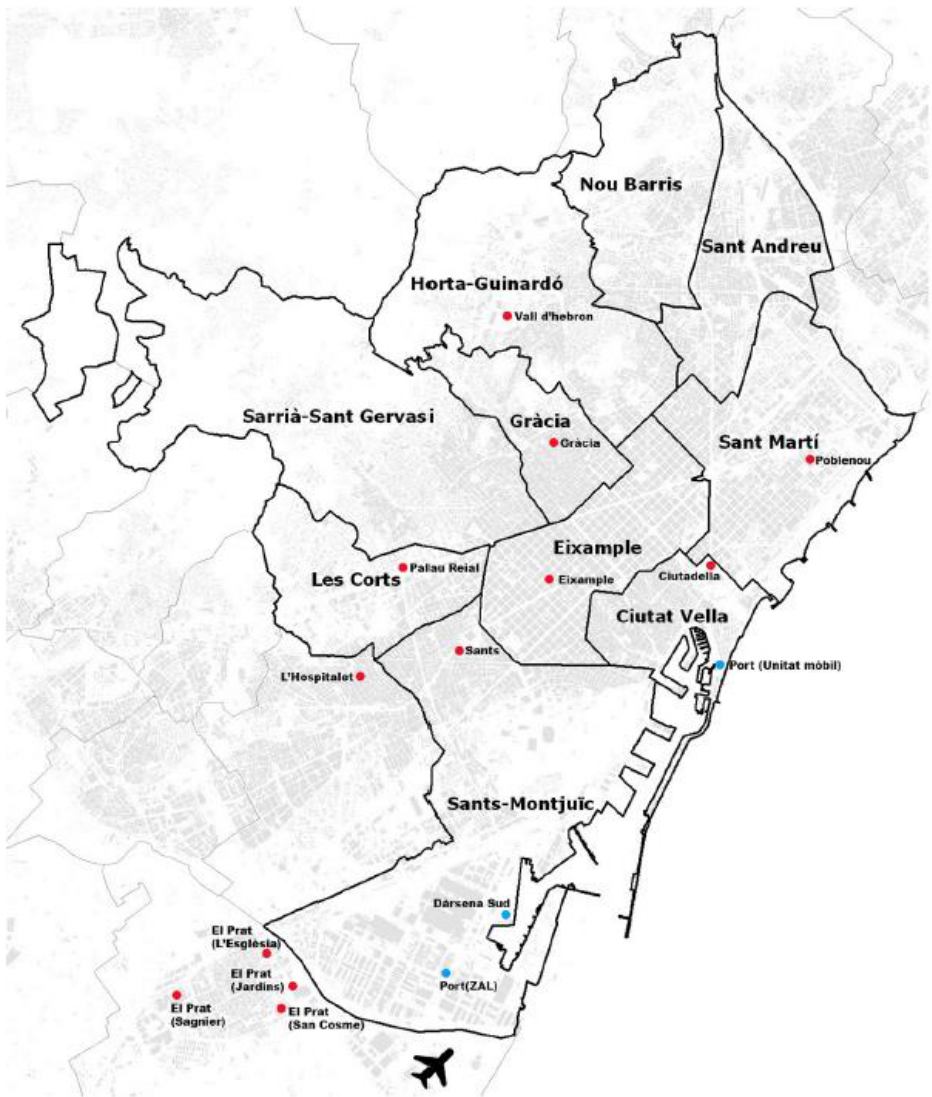
Figure 8. Area of study around the port of Barcelona. Reprinted with permission from ref. [44].